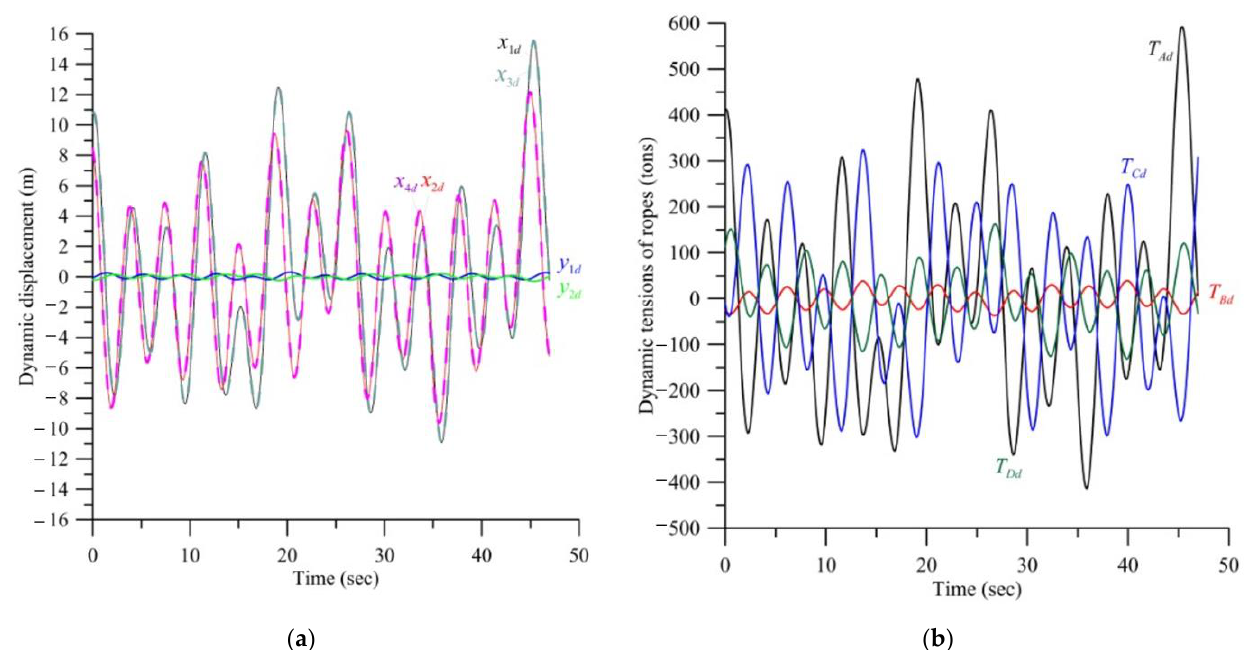
Figure 10. ( a ) Dynamic displacements of the four elements and ( b ) dynamic tensions of ropes under typhoon irregular wave for L C = 60 m, L D = 70